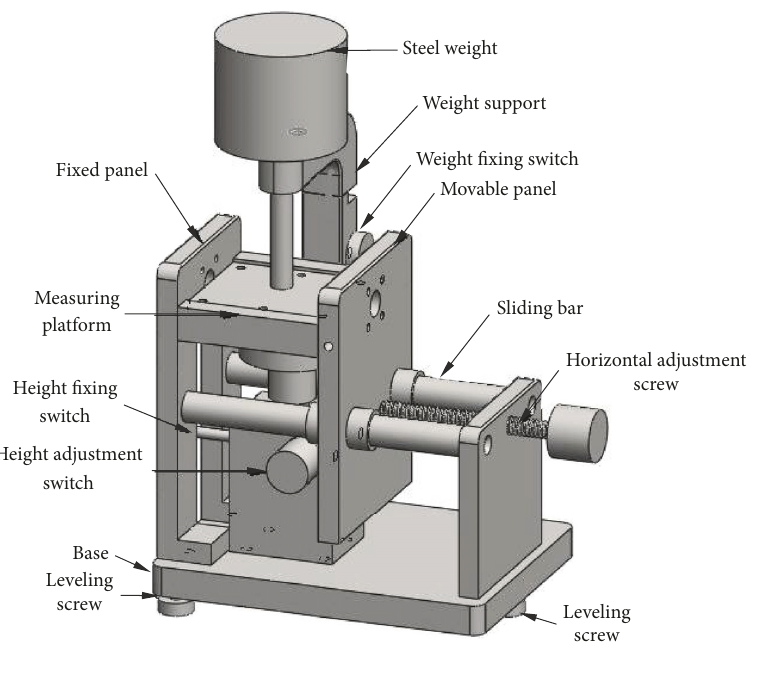
Figure 7: The structure of the measurement fixture.